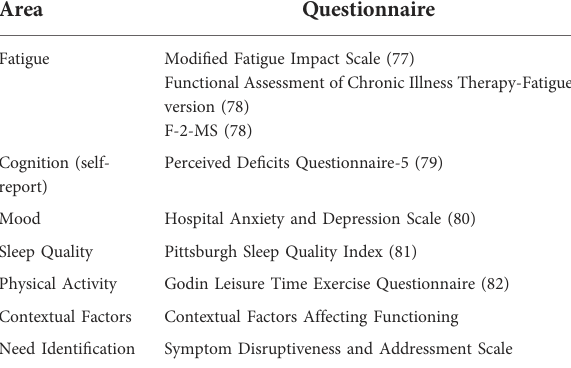
TABLE 2 Questionnaires included in the needs assessment